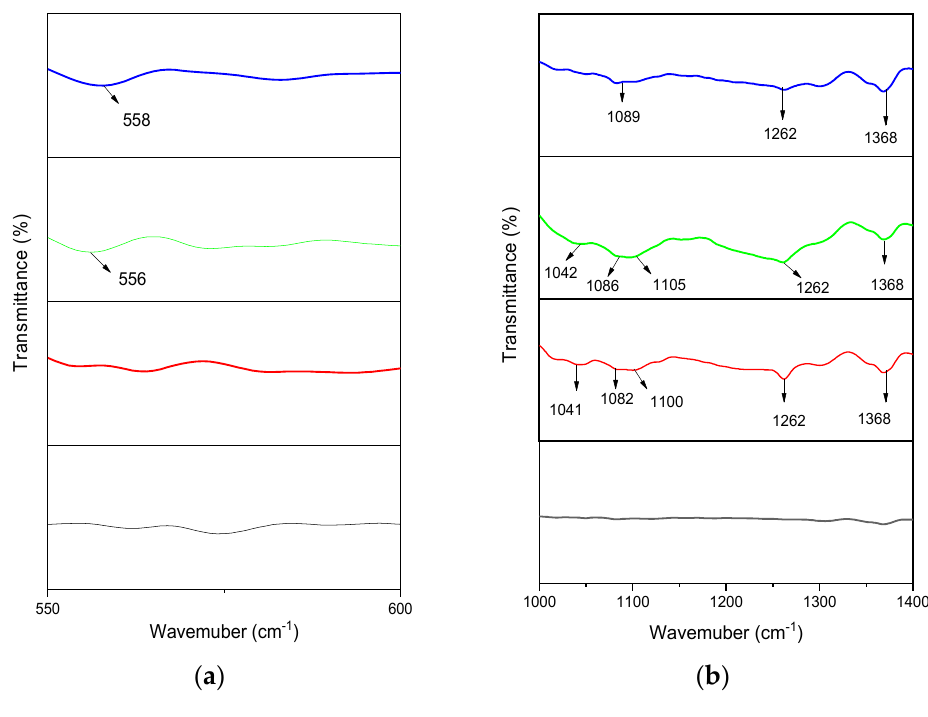
Figure 4. FTIR spectra ( a ) 550–600, ( b ) 1000–1400.